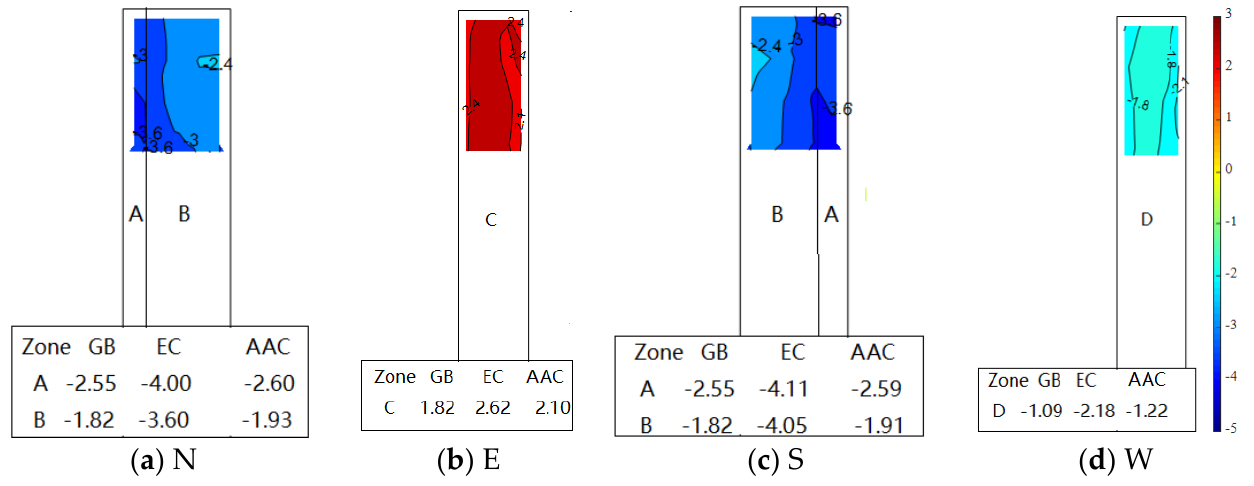
Figure 10. Contour of extreme pressure coefficient at 90 ° wind direction angle: ( a ) N, ( b ) E, ( c ) S, ( d ) W.